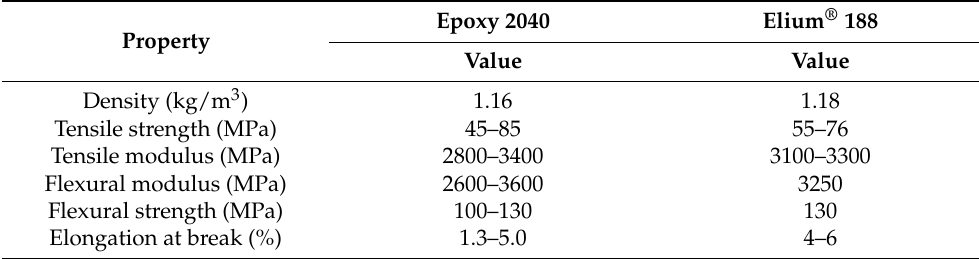
Table 2. Description of the mechanical properties of resins being